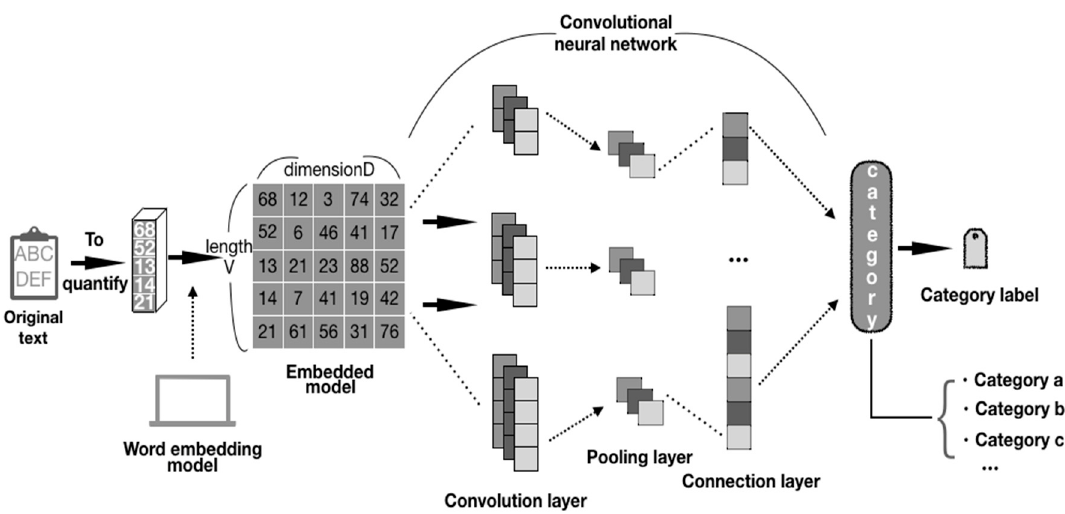
Figure 2. Convolutional neural network (CNN)-based text classification model.